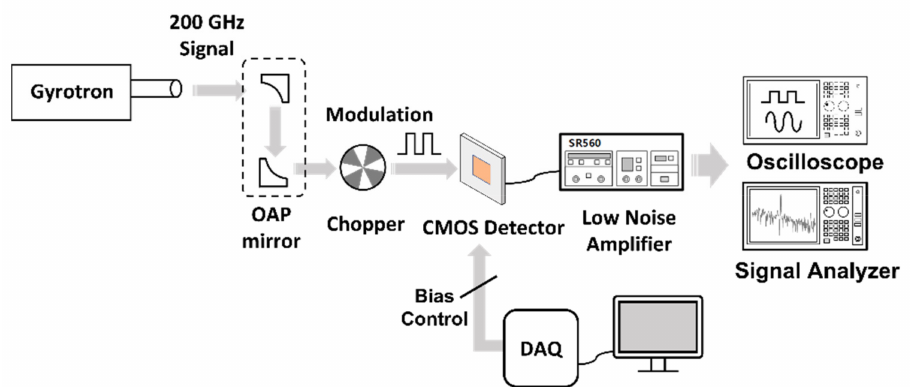
Figure 8. Measurement setup to analyze the performance of the proposed detector IC. An oscilloscope to measure R V and a signal analyzer to obtain noise-equivalent power have been